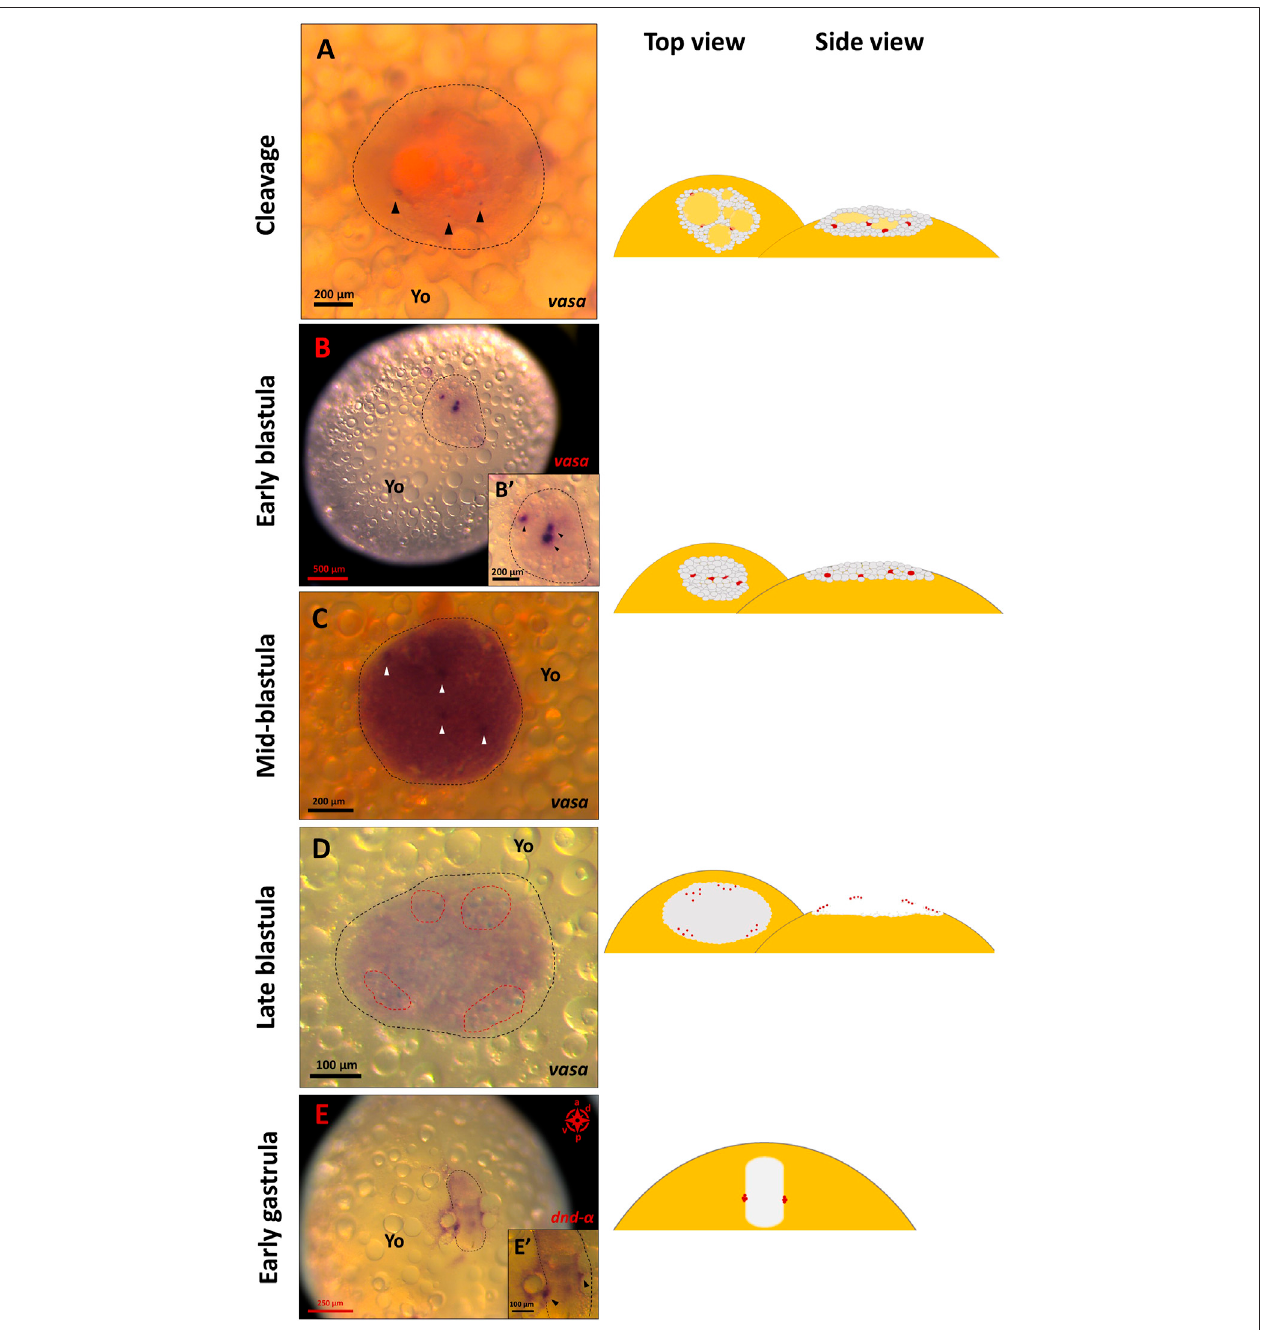
FIGURE 1 | PGC formation and migration in G. holbrooki . WISH panels showing the actual and schematic locations of PGC during G. holbrooki embryogenesis. The PGC markers, vasa or dnd- α signals at nine developmental stages are presented. The vasa -positive cells are fi rst detectable ( (A) , black arrowhead) emerging as a fewtinyspotsdistributedthroughoutthecellmass(n (cid:1) 3).Atearlyblastula (B) ,the vasa signalwasintensi fi edinafewdistinctiveregions(blackarrowheadinclose-upB ′ ) with asymmetric distribution (n (cid:1) 4). Later, four distinctive spots ( (C) , white arrowhead) are detectable buried underneath the super fi cial layer of cells (n (cid:1) 3). At late blastula (D) ,the vasa -positivesignalsincreaseandappear peripherallyassmallclusters(n (cid:1) 4).Atearlygastrula (E) ,thePGCscoalesceastwocompactclustersofcells (blackarrowheadintheclose-upE ′ )locatedatthemarginofthedome(n (cid:1) 4).Atlategastrula (F) ,thePGCswerelocatedattheposteriorhalfoftheembryo(n (cid:1) 3).During segmentationstages( (G) ,n (cid:1) 5and (H) ,n (cid:1) 4),thePGCclustersmigrateconvergentlyandanteriorly,andatearlypharyngula (I) ,theyeventuallyhomeatgenitalridge(red arrowheads) and form a bi-lobular presumptive gonad (n (cid:1) 7). The black dashed lines indicate the area of the cleavage plane and blastodisc (A,B) , and embryonic axis (E,F,G,H,I) respectively. The red dashed lines (D) show the signals clustered in four groups. The red dots in schematics represent relative position of the PGC marker signals. Op, optic bud; Yo, yolk; Seg, segments.